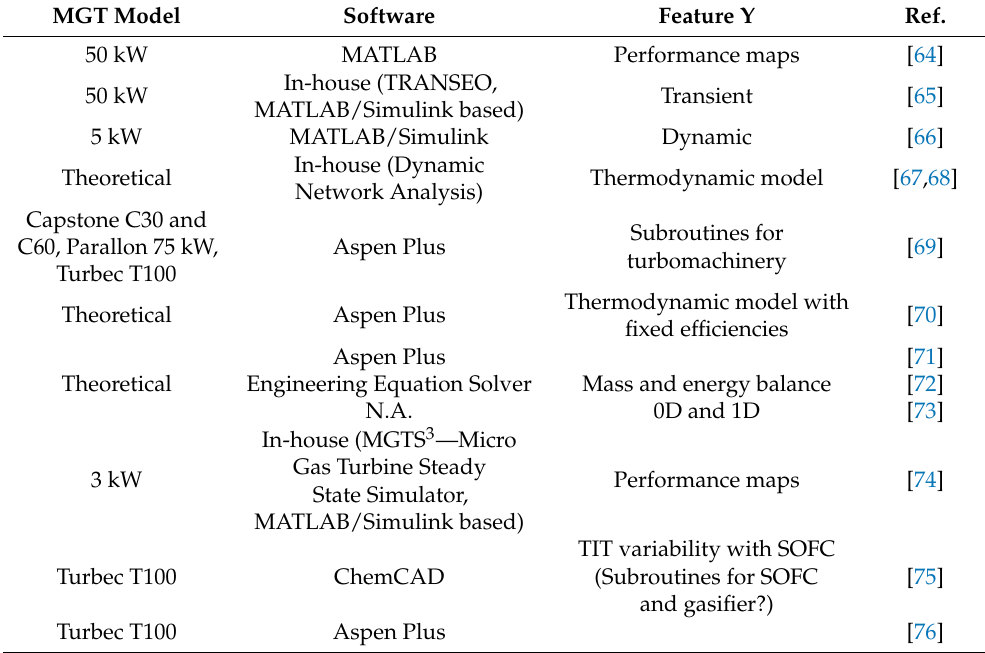
Table 5. MGT-SOFC plants reviewed.